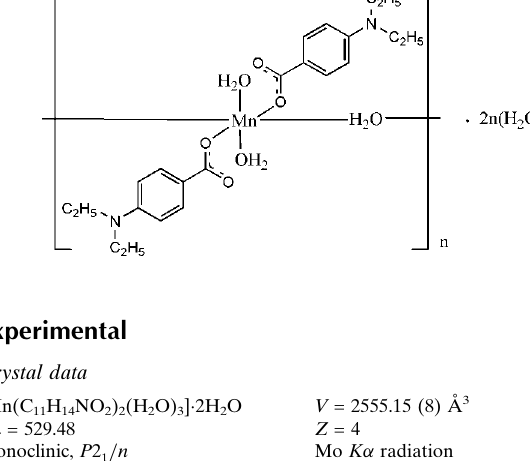
Data collection Bruker Kappa APEXII CCD area- detector diffractometer Absorption correction: multi-scan ( SADABS ; Bruker, 2005)